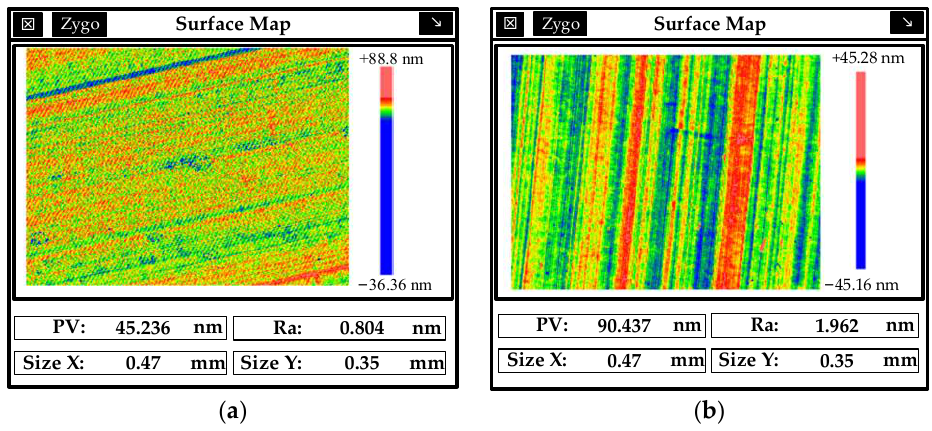
Figure 9. Surface roughness of the modified layer after turning. ( a ) Surface roughness of modified layer sample 1. ( b ) Surface roughness of modified layer sample 2.